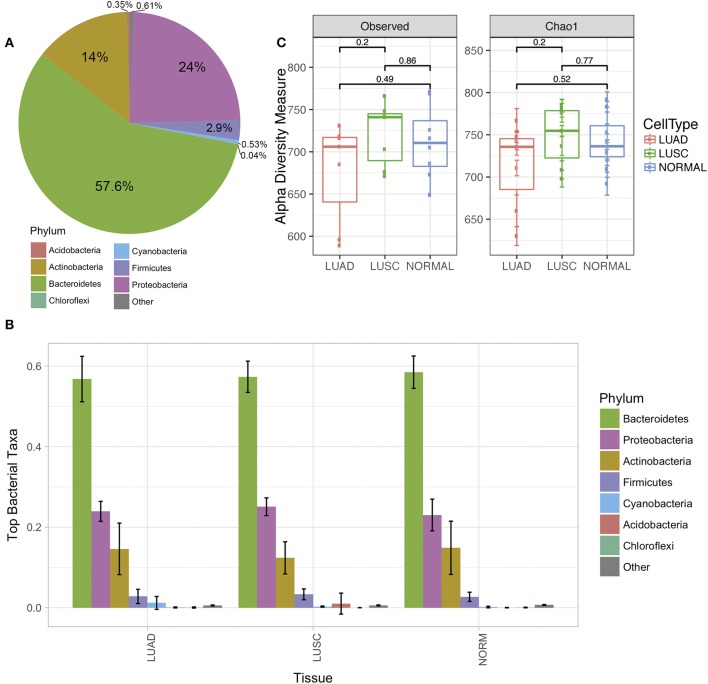
The diversity of lung microbiome derived from a normal cell and tumor cell of Non-small cell lung cancer (NSCLC) of the two subtypes adenocarcinoma (LUAD) and squamous cell carcinoma (LUSC). (A) The average of the phylum level pie chart of all lung samples in this study (N = 22). (B) Phylum level distribution (relative abundance) of microbial communities comparing paired normal (N = 8), LUAD (N = 7), and LUSC (N = 7) lung tissue patients (total N = 22). Each bar represents a fraction of the bacteria detected in a given sample. (C) Alpha diversity plot of the three groups of samples (normal, LUAD and LUSC) by observed and Chao1 model. The statistical comparisons of mean among the group were reported as p-values derived from Mann-Whitney test.